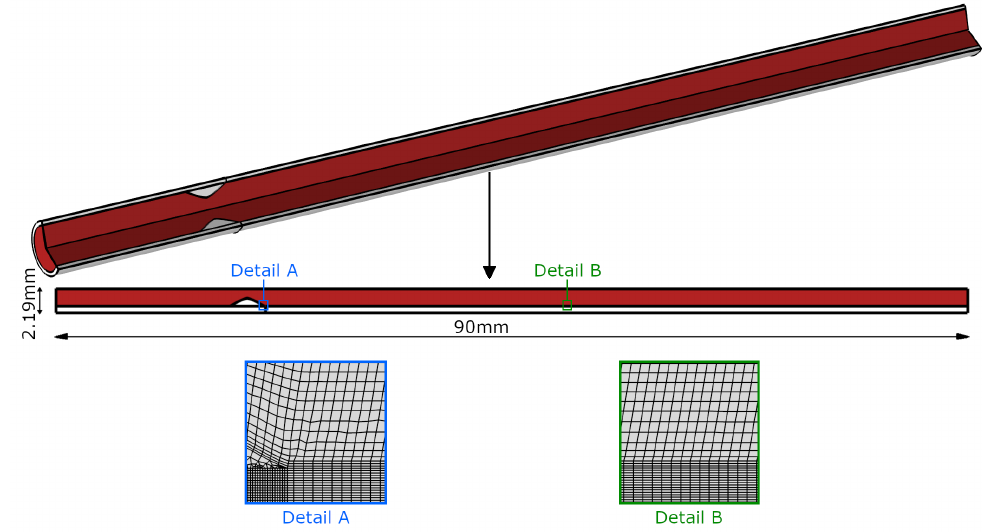
Figure 1. Two-dimensional axisymmetric geometry composed of lumen (in red), the arterial wall, and obstacle plaque (both in white color). Details ( A , B ) show the mesh near the endothelium at both sides (lumen and arterial wall) for the area near the obstacle plaque ( A ) and the area of development of the new plaque ( B